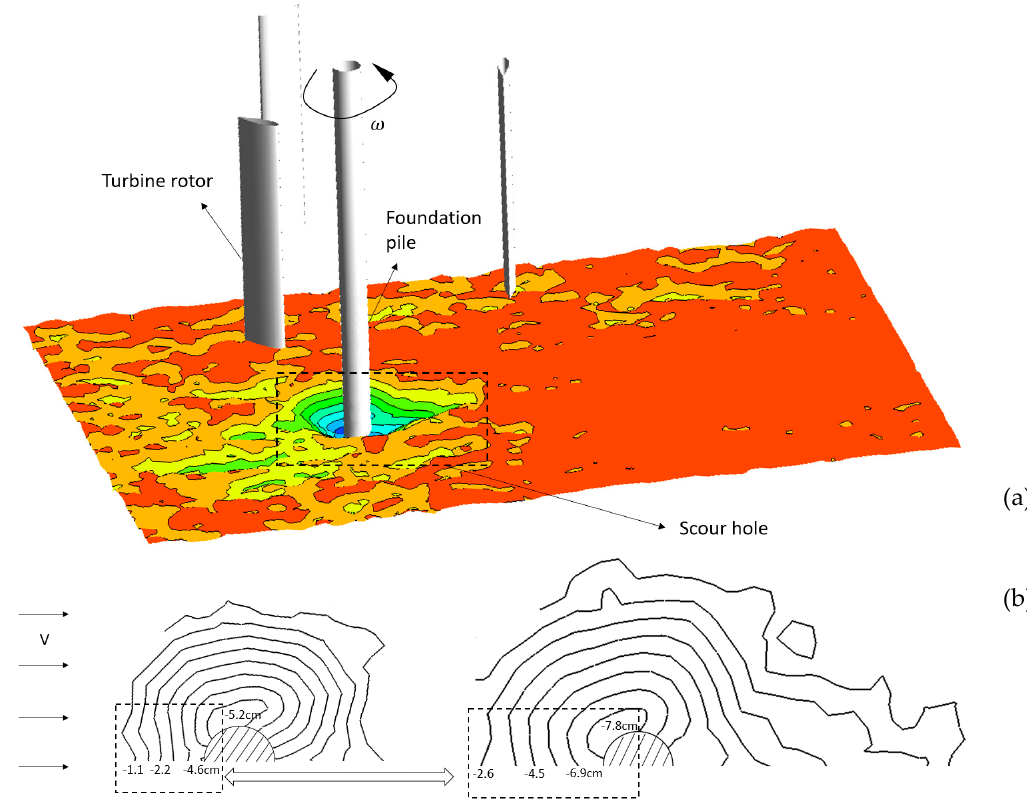
Figure 10. The topographic contours of the local scour shapes after scour equilibrium of model T2: ( a ) the seabed profiles after scour equilibrium simulated by the proposed scour model; ( b ) contour map of scour hole simulated by numerical model T1 (left), and contour map of scour hole simulated by numerical model T2 (right).